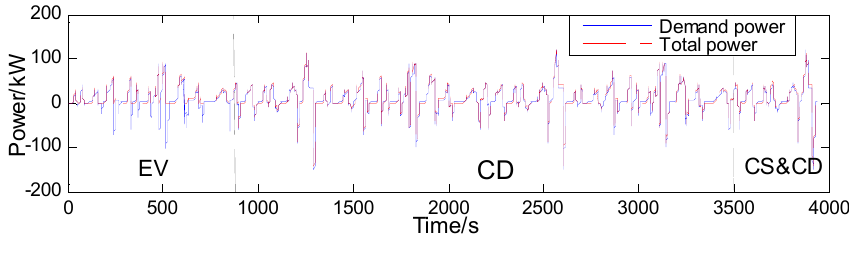
Figure 15. The power following